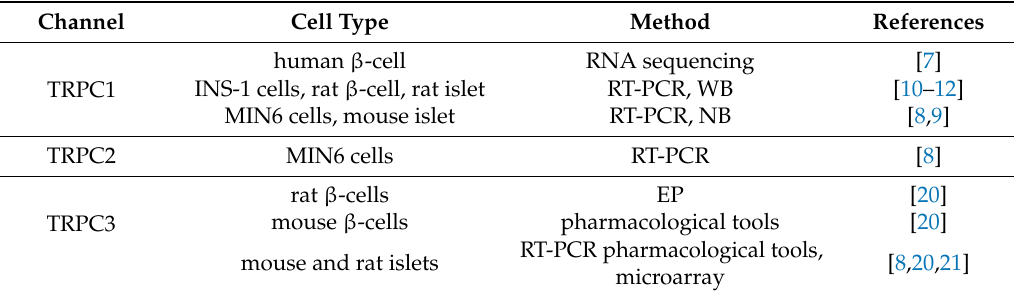
Table 1. TRP channels of native and transformed islet